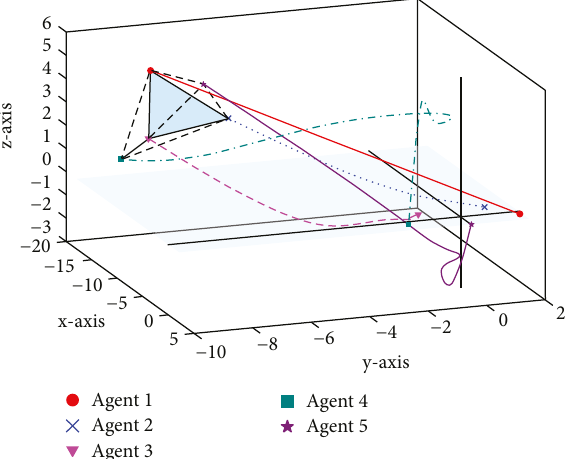
Figure 4: Trajectories of agents in a 3D space: agent ν Orientation 2, while agent ν 5 is in Orientation 1.